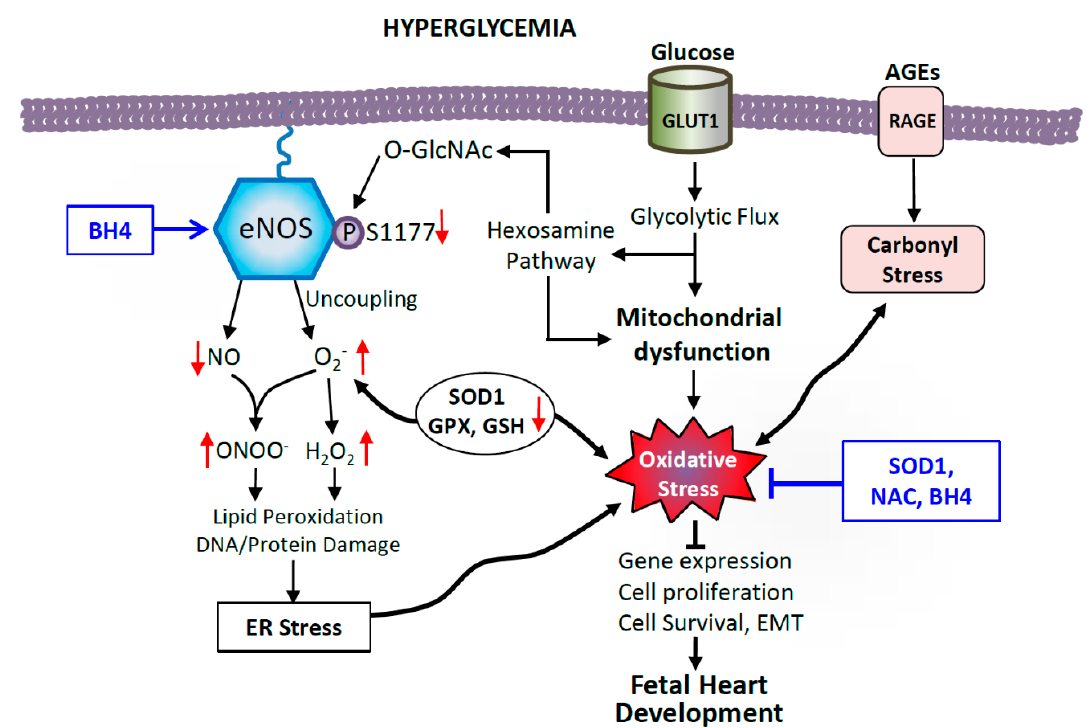
Figure 3. Possible mechanisms of hyperglycemia-induced cellular oxidative damage in the fetal heart. Excess glucose increases the rate of glycolytic metabolic pathways, overproducing electron donors that increase mitochondrial reactive oxygen species (ROS) production. Coupled with impaired antioxidant defenses including lower levels of superoxide dismutase 1 (SOD), glutathione peroxidase (GPX) and reduced glutathione (GSH), this leads to oxidative stress in diabetes. Glycolysis intermediate fructose-6-phosphate also feeds into the hexosamine pathway to produce UDP-N-acetylglucosamine (UDP-GlcNAc), which leads to impairment of endothelial nitric oxide synthase (eNOS) function by O-GlcNAc modification of eNOS at serine 1177, the site of phosphorylation by Akt activation. Oxidative stress also causes eNOS to undimerize and produce superoxide, which reacts with NO to potentiate oxidative and nitrosative stress. Additionally, advanced glycation end-products (AGEs), though binding to receptors of AGEs (RAGE) induce carbonyl stress and promote ROS. Dysfunctional eNOS and oxidative stress alter gene expression, cell proliferation, survival, and inhibit epithelial-to-mesenchymal transition (EMT), leading to CHDs, which can be ameliorated by SOD1 overexpression, and maternal treatment with N-acetylcysteine (NAC) and sapropterin (BH4).